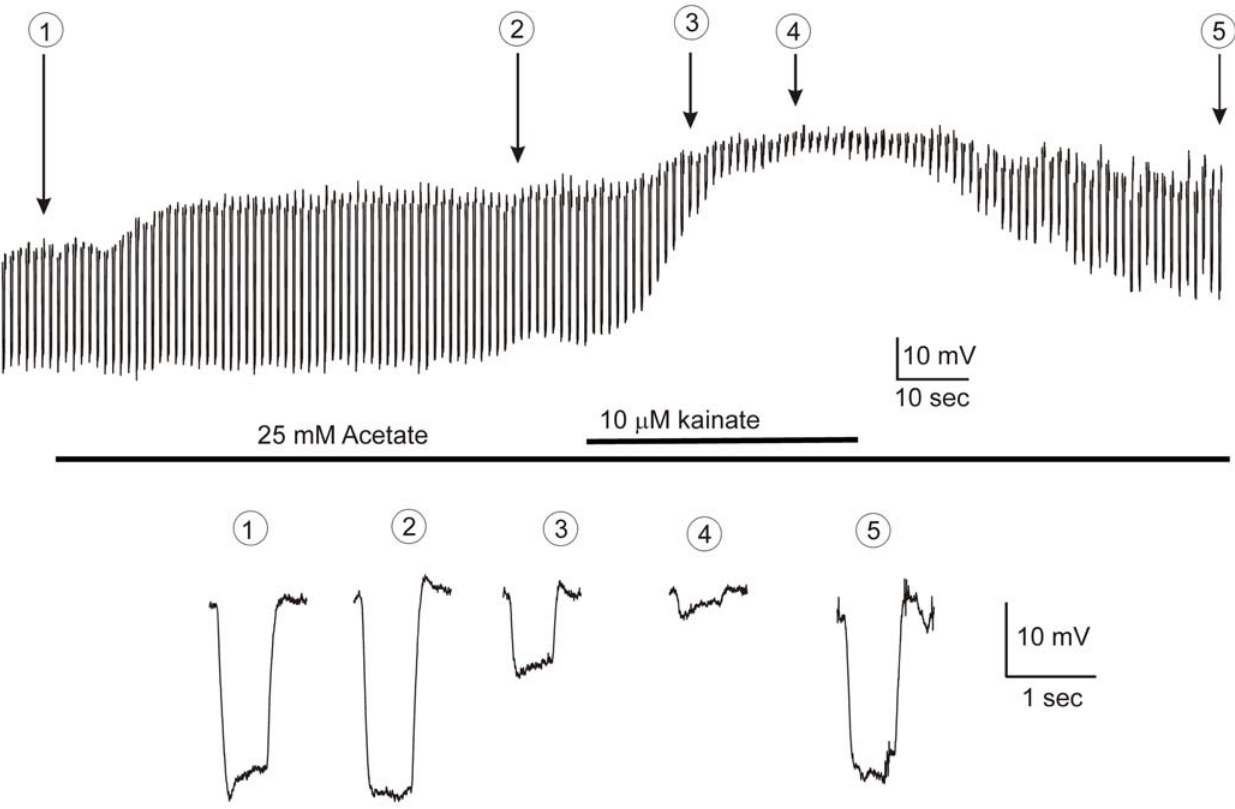
Figure 11. Glutamate-gated channels are able to mediate feedback in the presence of acetate in the isolated goldfish retina. Responses of a monophasic horizontal cell to 550 nm light (I=1 log) during application of acetate and kainate. Expanded light responses at the time points indicated by the arrows, are given below. 1) light response in control with a feedback-induced roll-back response. 2) light-responses in the presence of acetate. The feedback-induced roll-back response has disappeared without significant changes in the light response amplitude. 3) light- responses after additional application of 10 m M kainate. Despite a reduction in the amplitude of the light response, the feedback-induced roll-back response reappears again after opening a fraction of the glutamate-gated channels with a non-saturating concentration of kainate. 4) Light responses after longer superfusion of kainate. As horizontal cells depolarize further, their light responses get smaller, but there is still a substantial feedback- induced roll-back response. 5) Light response after washout of kainate; note that the horizontal cell hyperpolarizes, the amplitude of the light response increases, and the roll-back response is again no longer present.